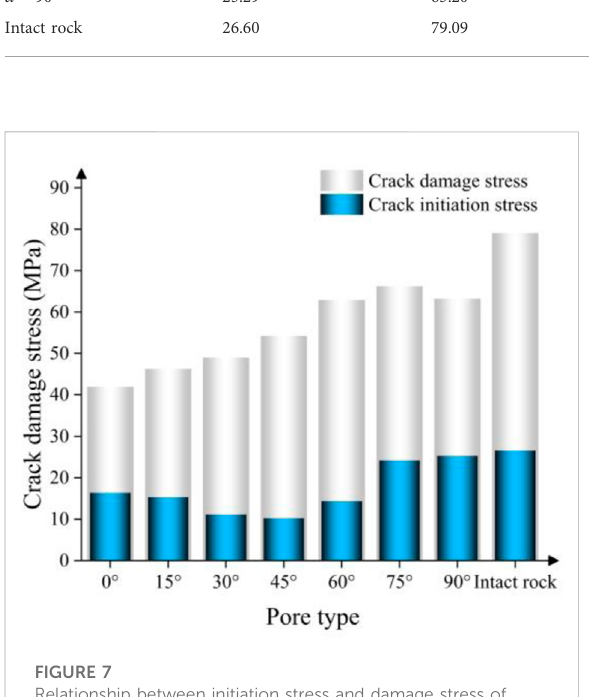
FIGURE 7 Relationship between initiation stress and damage stress of the intact rock model and single fracture-hole rock with different fracture